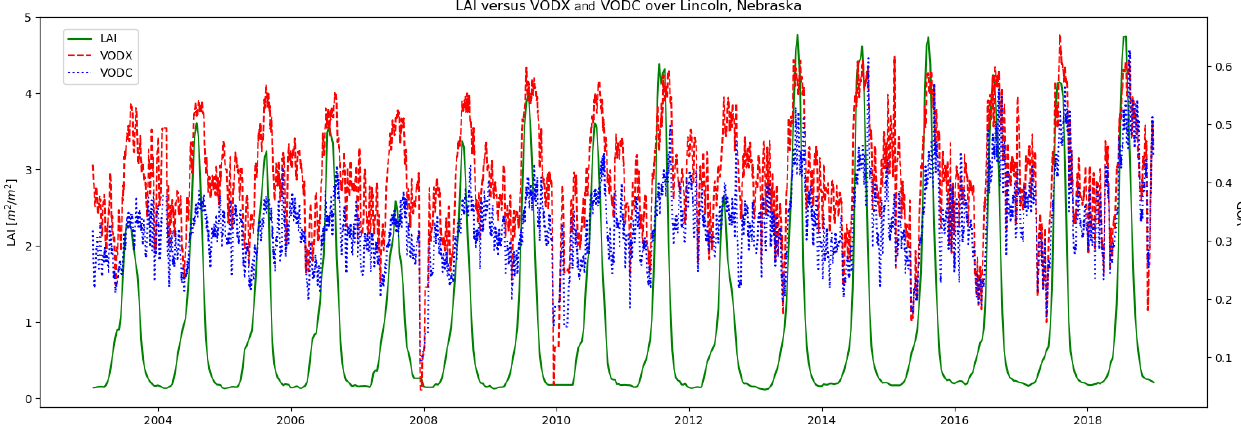
Figure 2. A time series showing the response of CGLS LAI (solid green line), VODCA VODX (dashed red line), and VODCA VODC (blue, dotted) over Lincoln, Nebraska, from